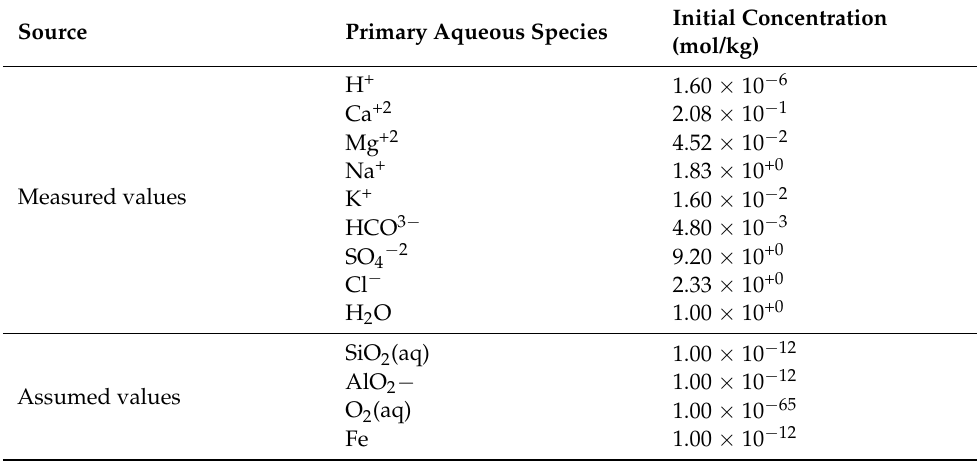
Table 5. Initial concentrations of primary aqueous species for